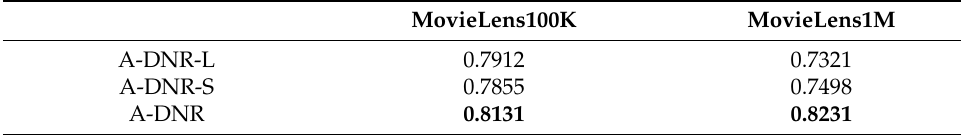
Table 5. The impact of user long-term and short-term preferences on HR@10.